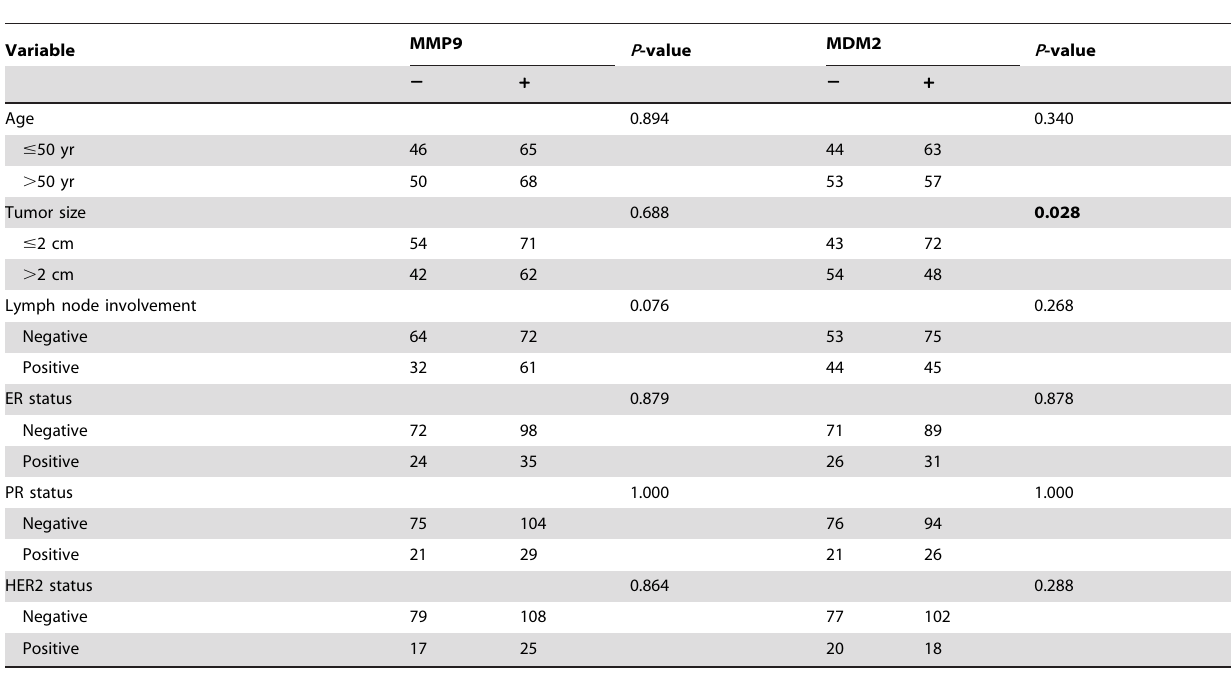
Table 1. Correlation between the expression of MMP9 and MDM2 with clinicopathological factors in tissue samples of IDC.